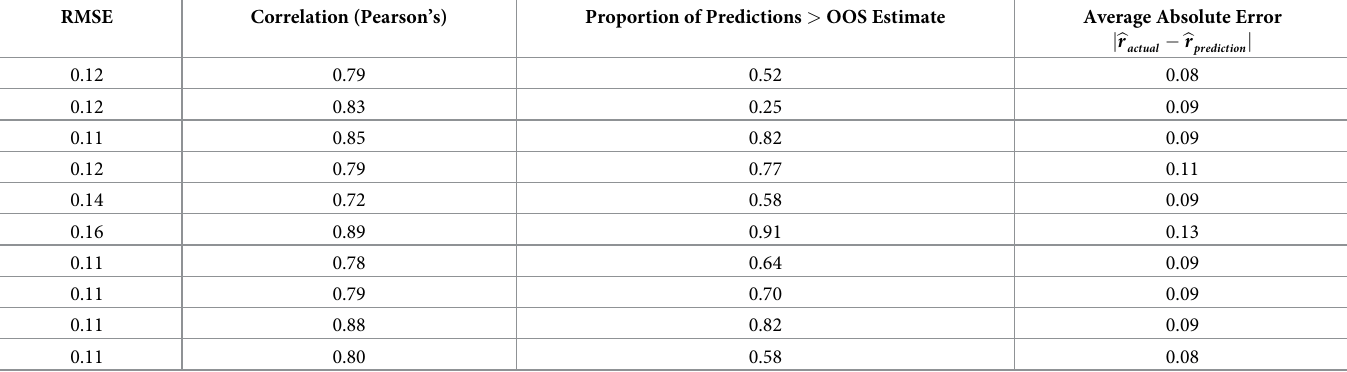
Table 5. Validation metrics for 10 random cross-validation sets. For each validation set the following metrics were calculated: RMSE, Pearson’s correlation coefficient, proportion of predictions exceeding the OOS estimates, and average absolute error (average of the absolute value of the difference between predicted and actual raptor average probability of